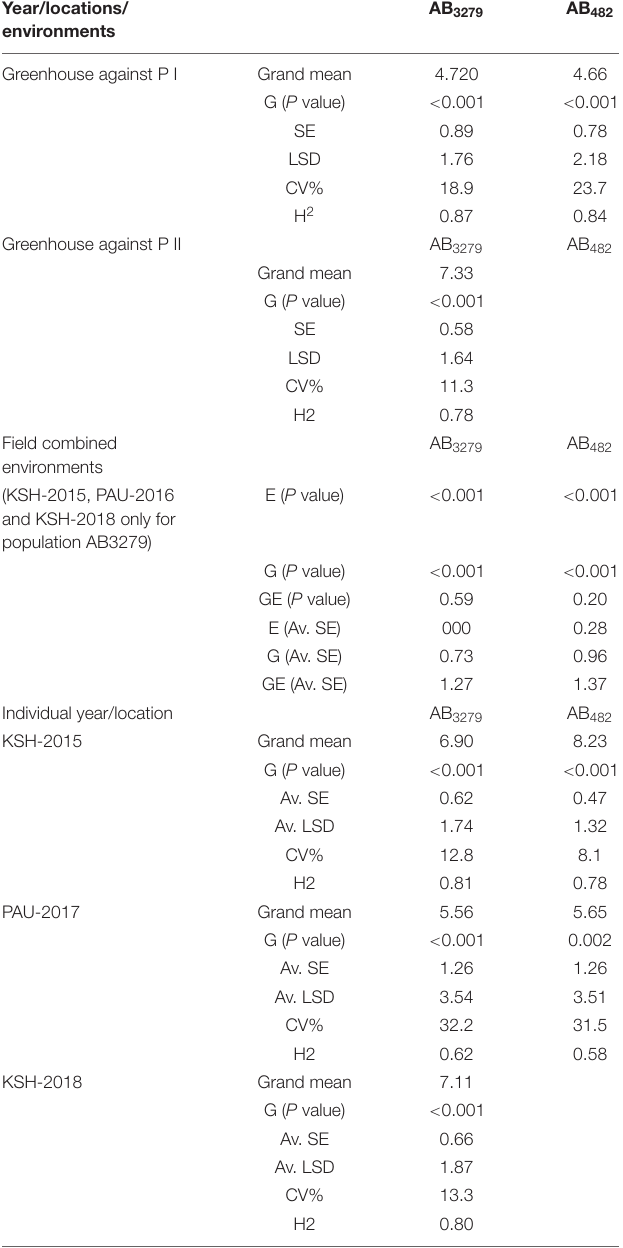
TABLE 2 | Analysis of variance for AB scores of the chickpea recombinant inbred line (RIL) AB 3279 and AB 482 populations under greenhouse conditions